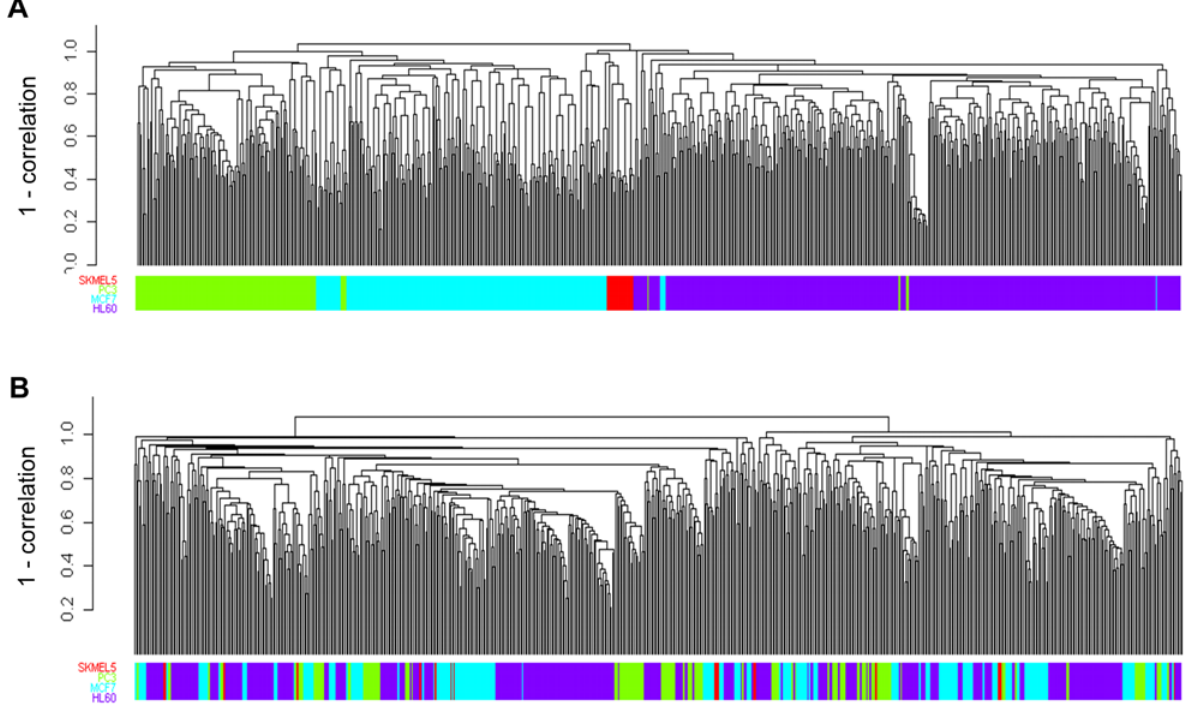
Fig 2. Hierarchical clustering of CMap instances less dominated by cell-type when clustering is based on gene-set/tag enrichment scores. Dendrograms are hierarchical clustering of CMap instances based on gene expression (A) and tag enrichment score (B). Colors in color bar below dendogram respectively represent the cell lines SKMEL5 (red), PC3 (green), MCF7 (blue), and HL60 (purple). For each instance top-300 genes or tags with the top-300 expression log-ratios or ES scores were selected for clustering based on Pearson distance metric and average linkage.